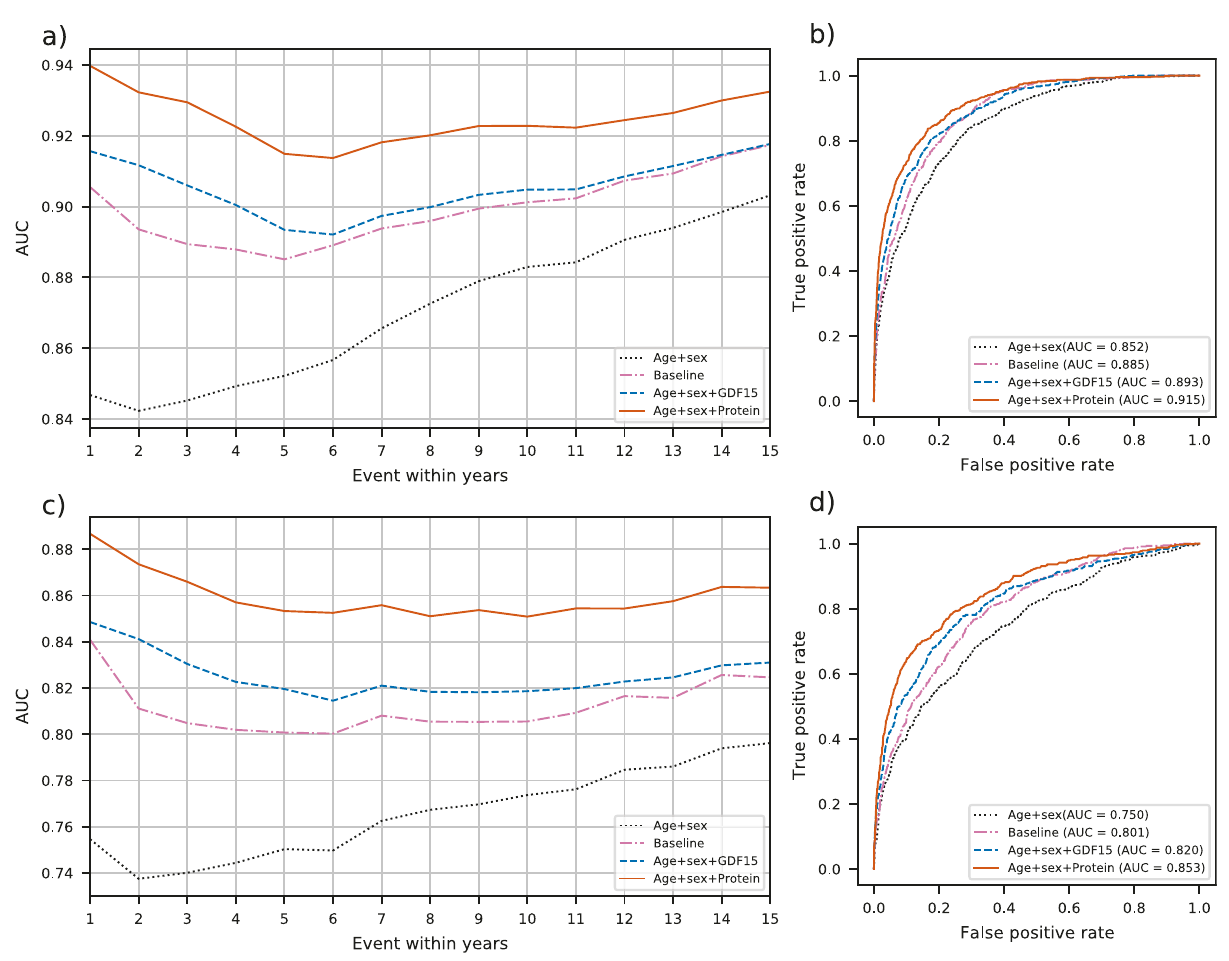
Fig. 1 Discrimination power of different models for death within 1,2, … ,15 years. a AUCs for all participants, N = 6893. b ROC curves for death within 5 years for all participants. c AUCs for participants older than 60, N = 3052. d ROC curves for death within 5 years for participants older than